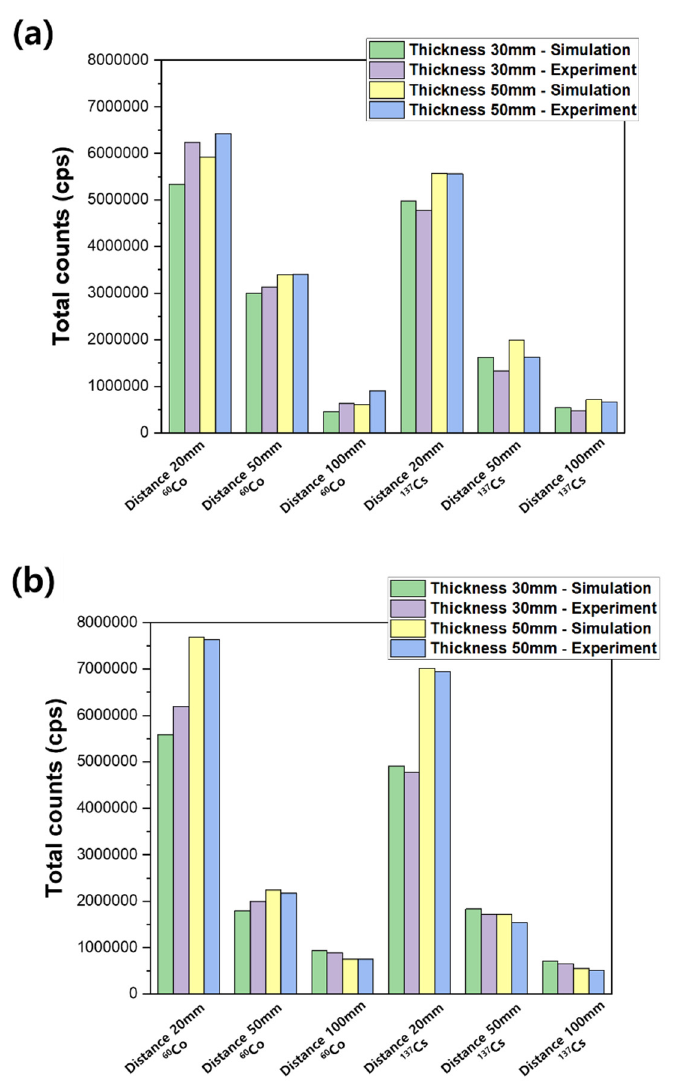
Figure 12. Total counts and errors of 30 mm and 50 mm calculated using GEANT4: ( a ) commercial plastic scintillator; ( b ) CdS/ZnS-loaded plastic scintillator.